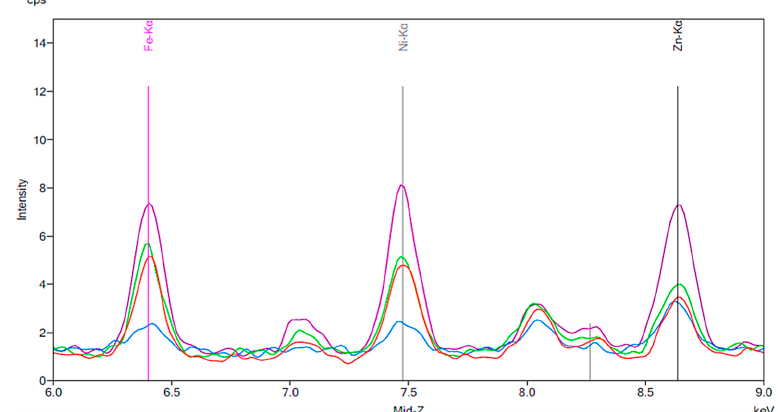
Figure 3. Spectrum displaying the results of an experiment in which new artificial teeth were exposed to coffee. The red peaks correspond to the new artificial tooth before being exposed to coffee. The green peaks represent the same artificial tooth following 24 h of exposure to coffee.